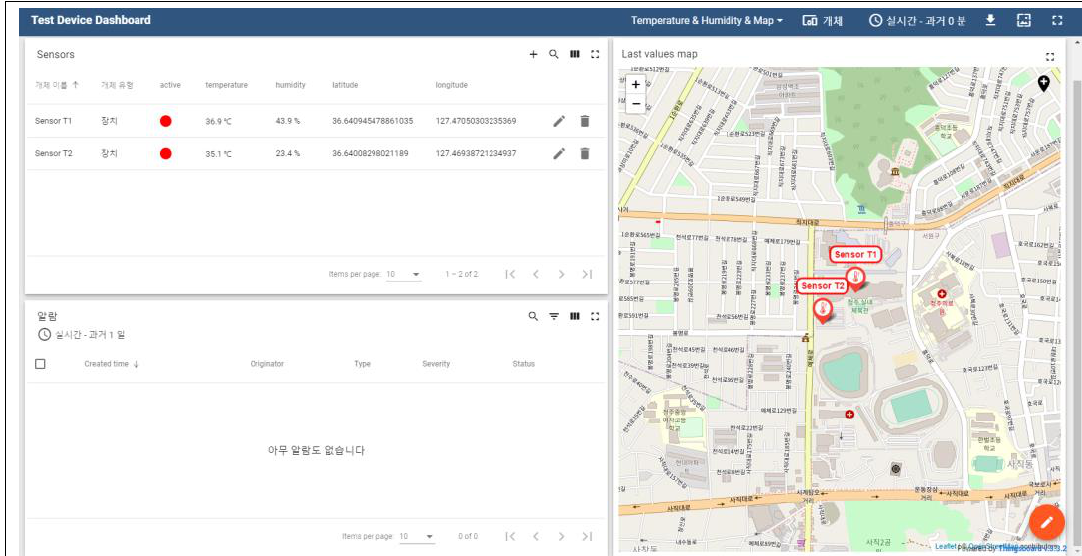
Figure 10. First dashboard screen captured. (For your information, In this figure, the non-English term “ 평균 ” means “ average ” in English) .